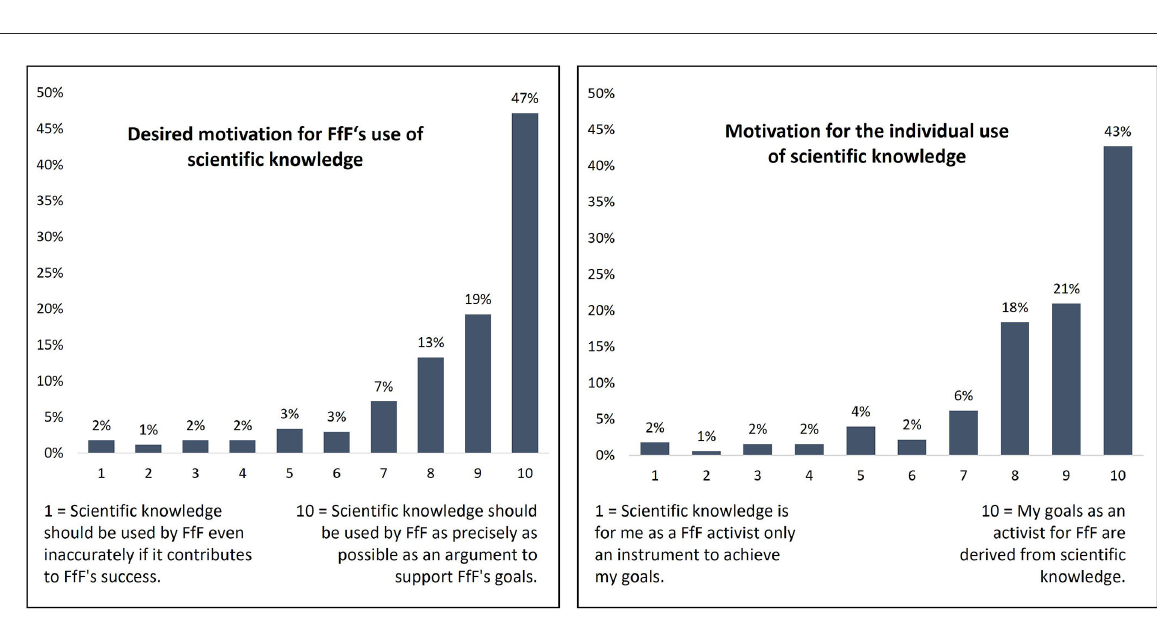
FIGURE4 Motivations for the use of scientific knowledge by Fridays for Future activists on the movement and individual level in the range between “as an instrument” and “as